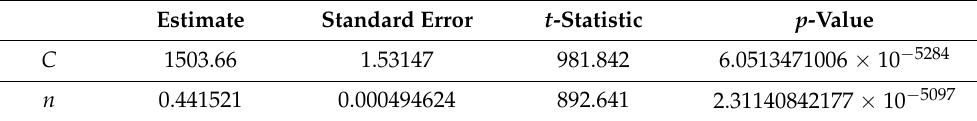
Table 8. Results from regression analysis for Swift’s model.